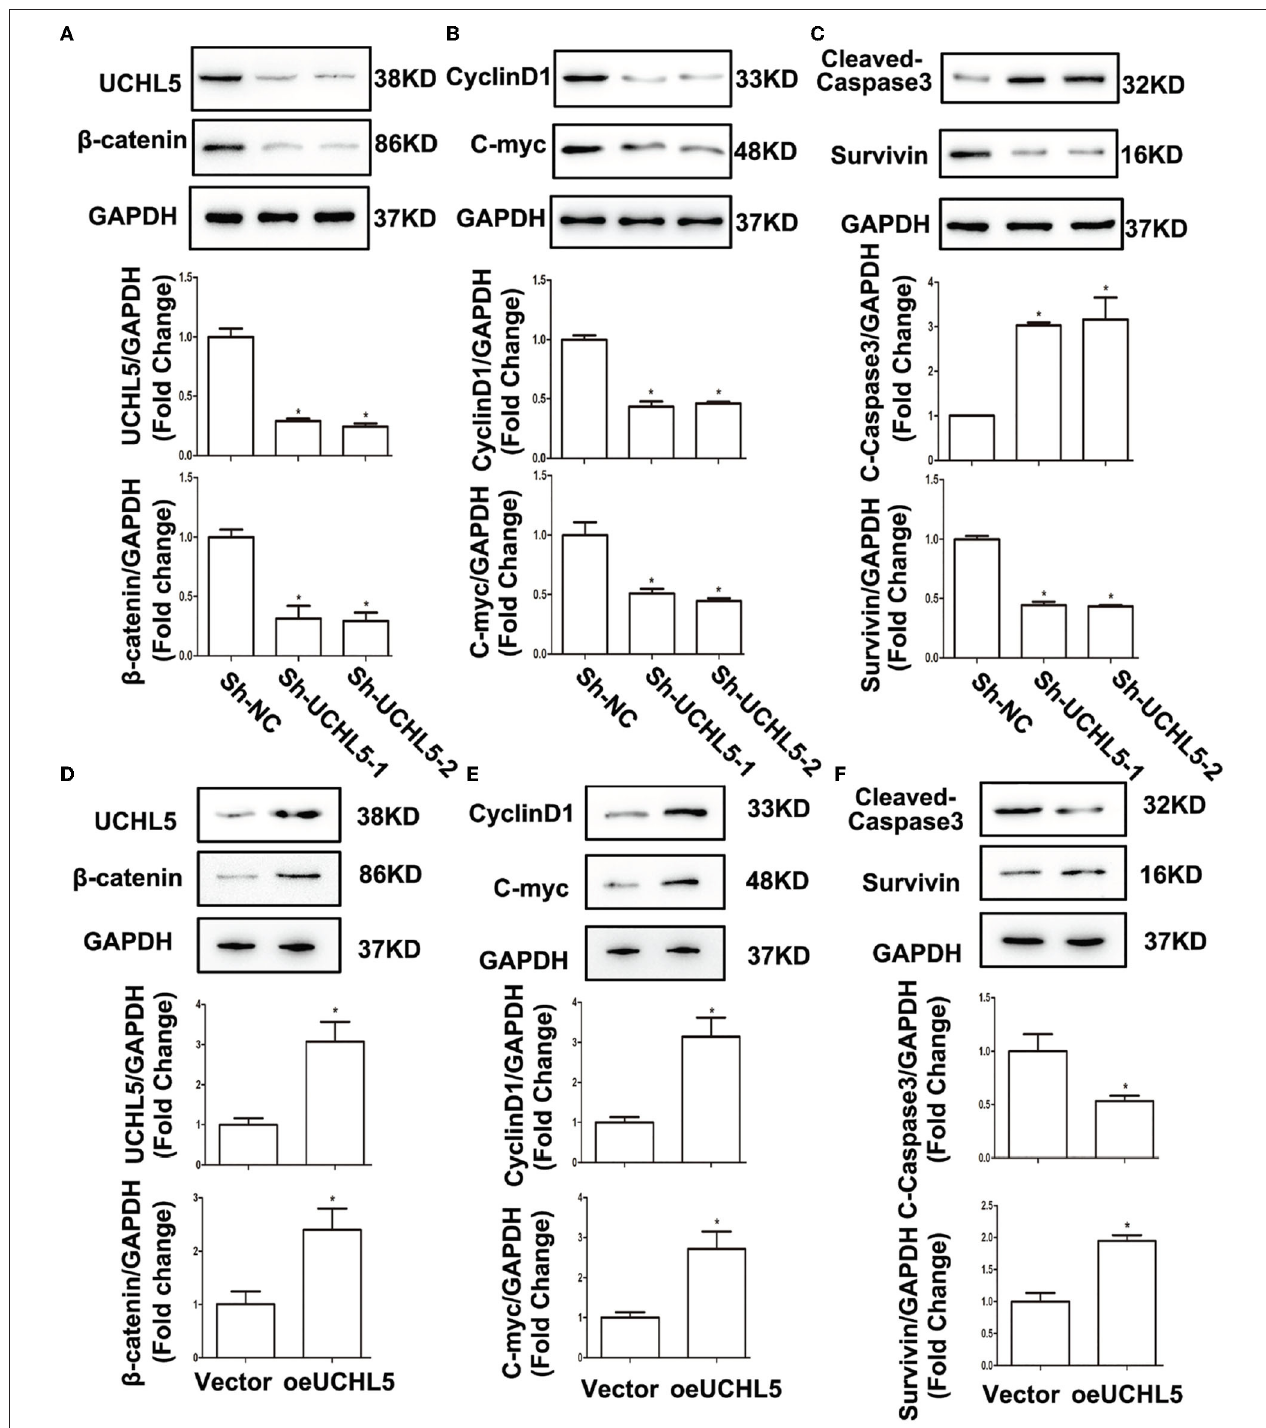
FIGURE 5 | UCHL5 activated Wnt/ β -catenin signaling and affected the expression of its target genes. (A) Relative protein levels of UCHL5 and β -catenin were detected by WB in HCE-1-A cells at 48h after shRNA lentiviral infection ( N = 3 times). * P < 0.05 vs. sh-NC. (B) Relative levels of cell cycle–related protein CyclinD1 and cell proliferation-related protein C-myc. ( N = 3 times). * P < 0.05 vs. sh-NC. (C) Relative levels of cell apoptosis-related protein cleaved-caspase3 and anti-apoptosis protein Survivin ( N = 3 times). * P < 0.05 vs. sh-NC. (D) Relative protein levels of UCHL5 and β -catenin were detected by WB in AN3-CA cells at 48 h after infected with overexpressed lentiviral vectors ( N = 3 times). * P < 0.05 vs. empty vector. (E) Relative levels of CyclinD1 and C-myc ( N = 3 times). * P < 0.05 vs. empty vector. (F) Relative levels of cleaved-caspase3 and Survivin ( N = 3 times). * P < 0.05 vs. empty vector.